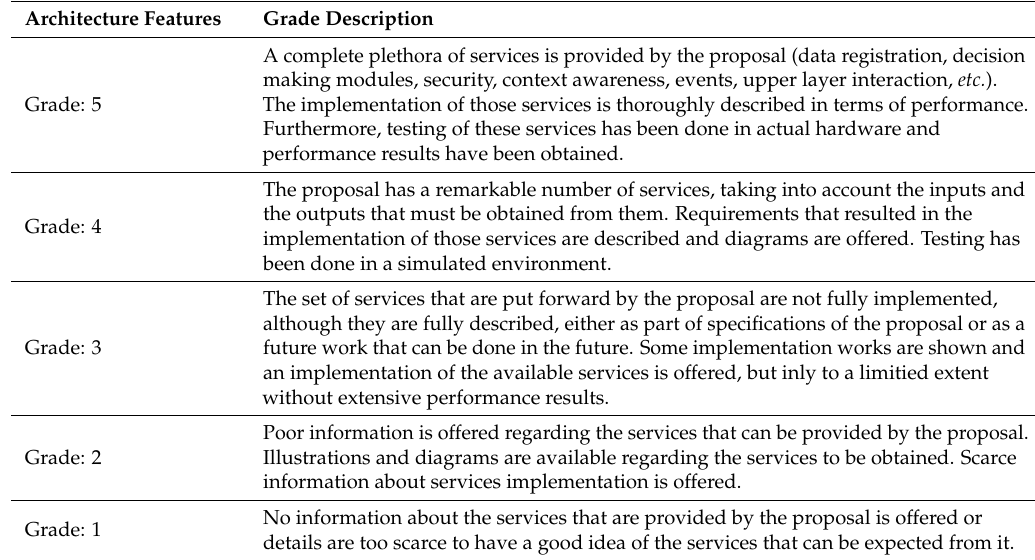
Table 4. System services assessment.